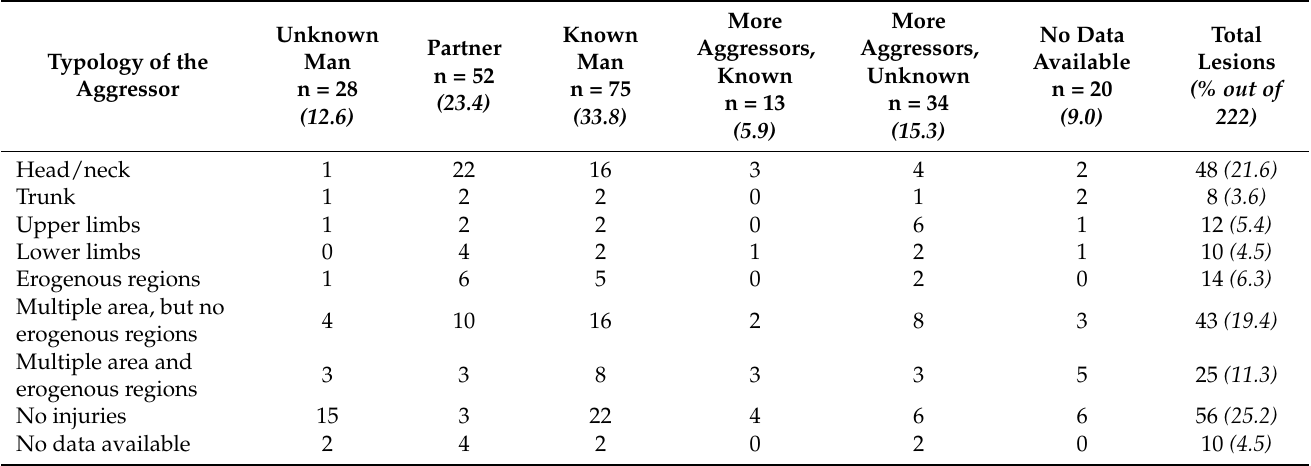
Table 4. Distribution of lesions in relation to the typology of the